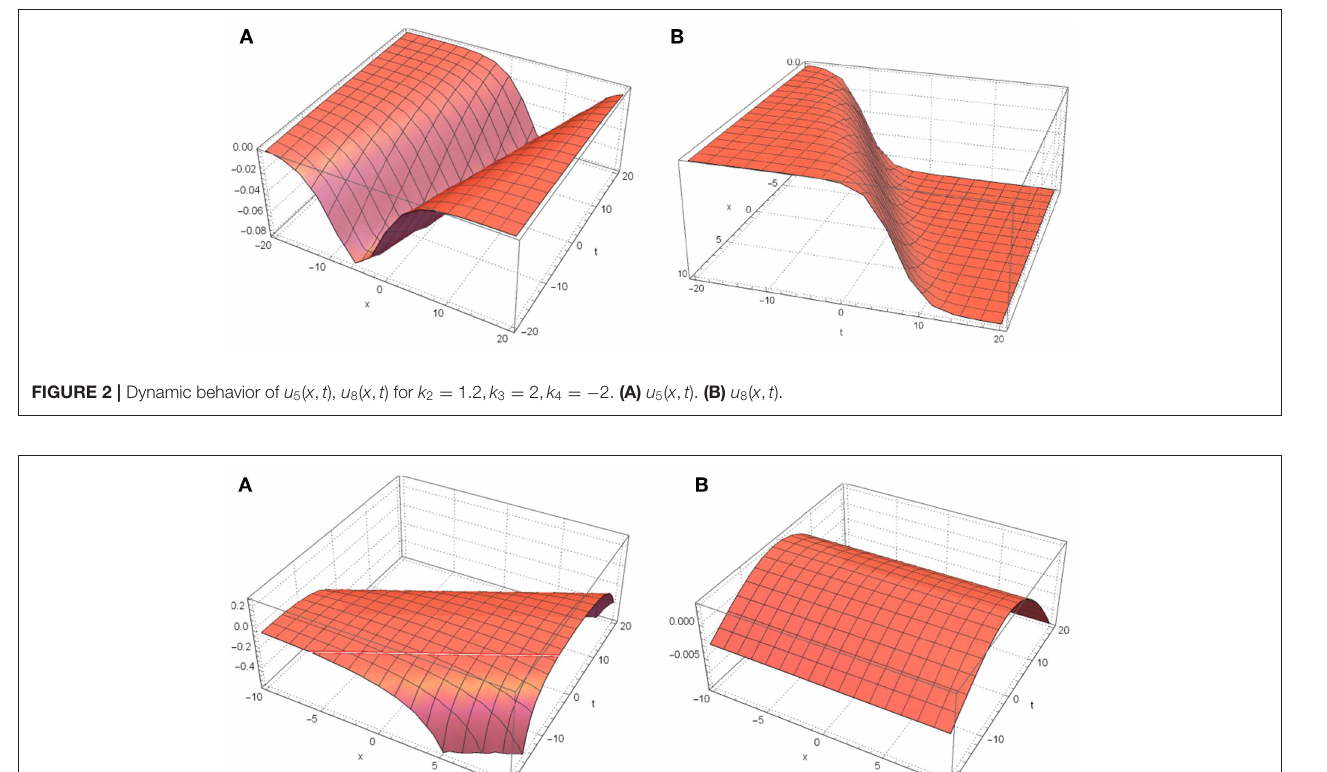
Frontiers in Physics |